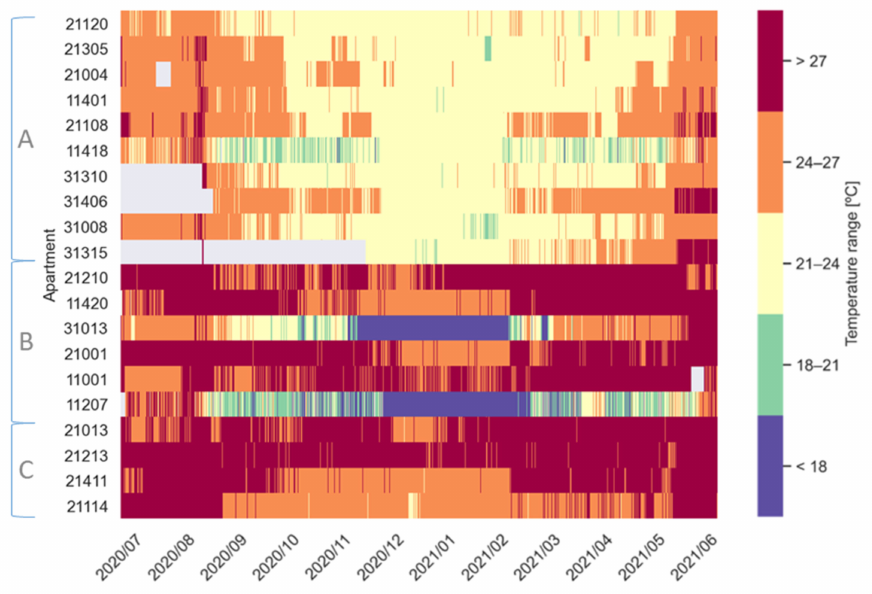
Figure 29. Hourly values of indoor temperature from 20 selected